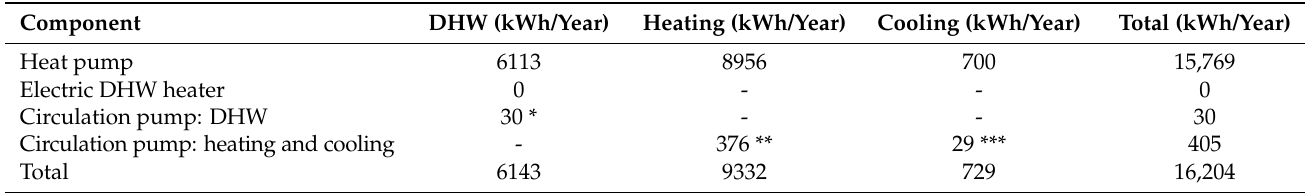
Table 5. Annual energy consumption of the reference system.